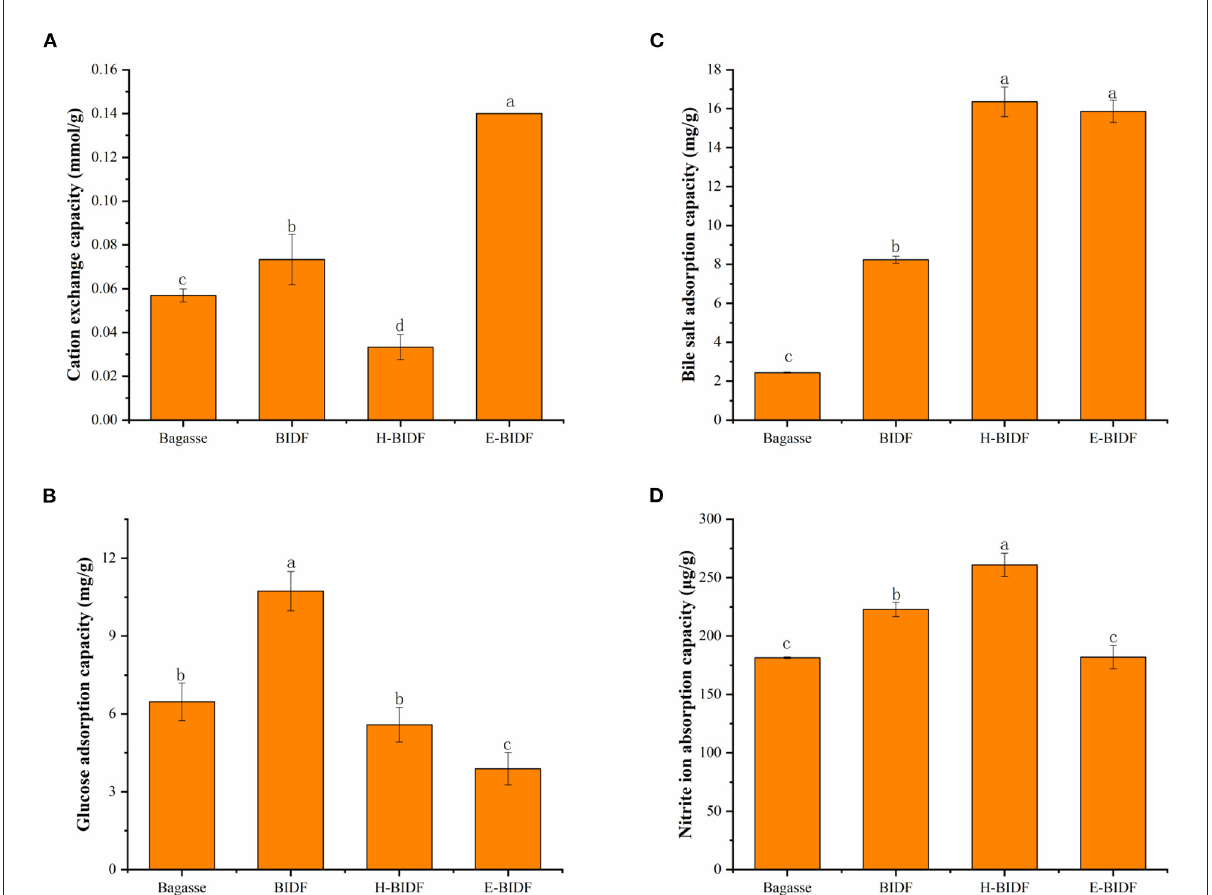
FIGURE7 The CEC (A) , GAC (B) , BSAC (C) , and NIAC (D) of bagasse, BIDF, H-BIDF and E-BIDF. Different letters (a, b, c, d) denote significantly different in the column ( p <